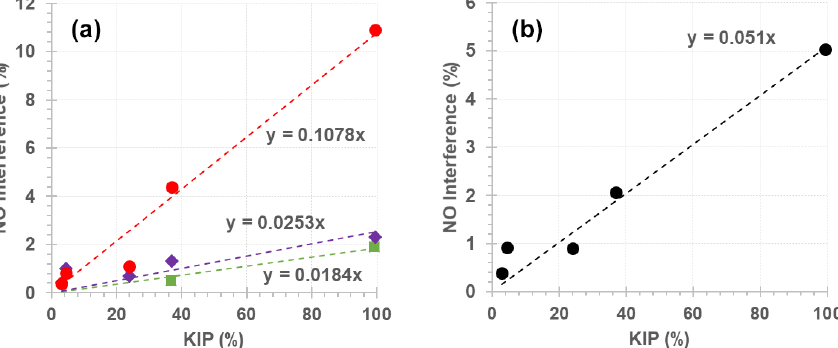
Figure 5. Relationship between measured NO interference (%) and kinetic interference potential (KIP; %) for monitors 1 (green), 3 (purple), 4 (red) and the average of the observed NO interference across all instruments